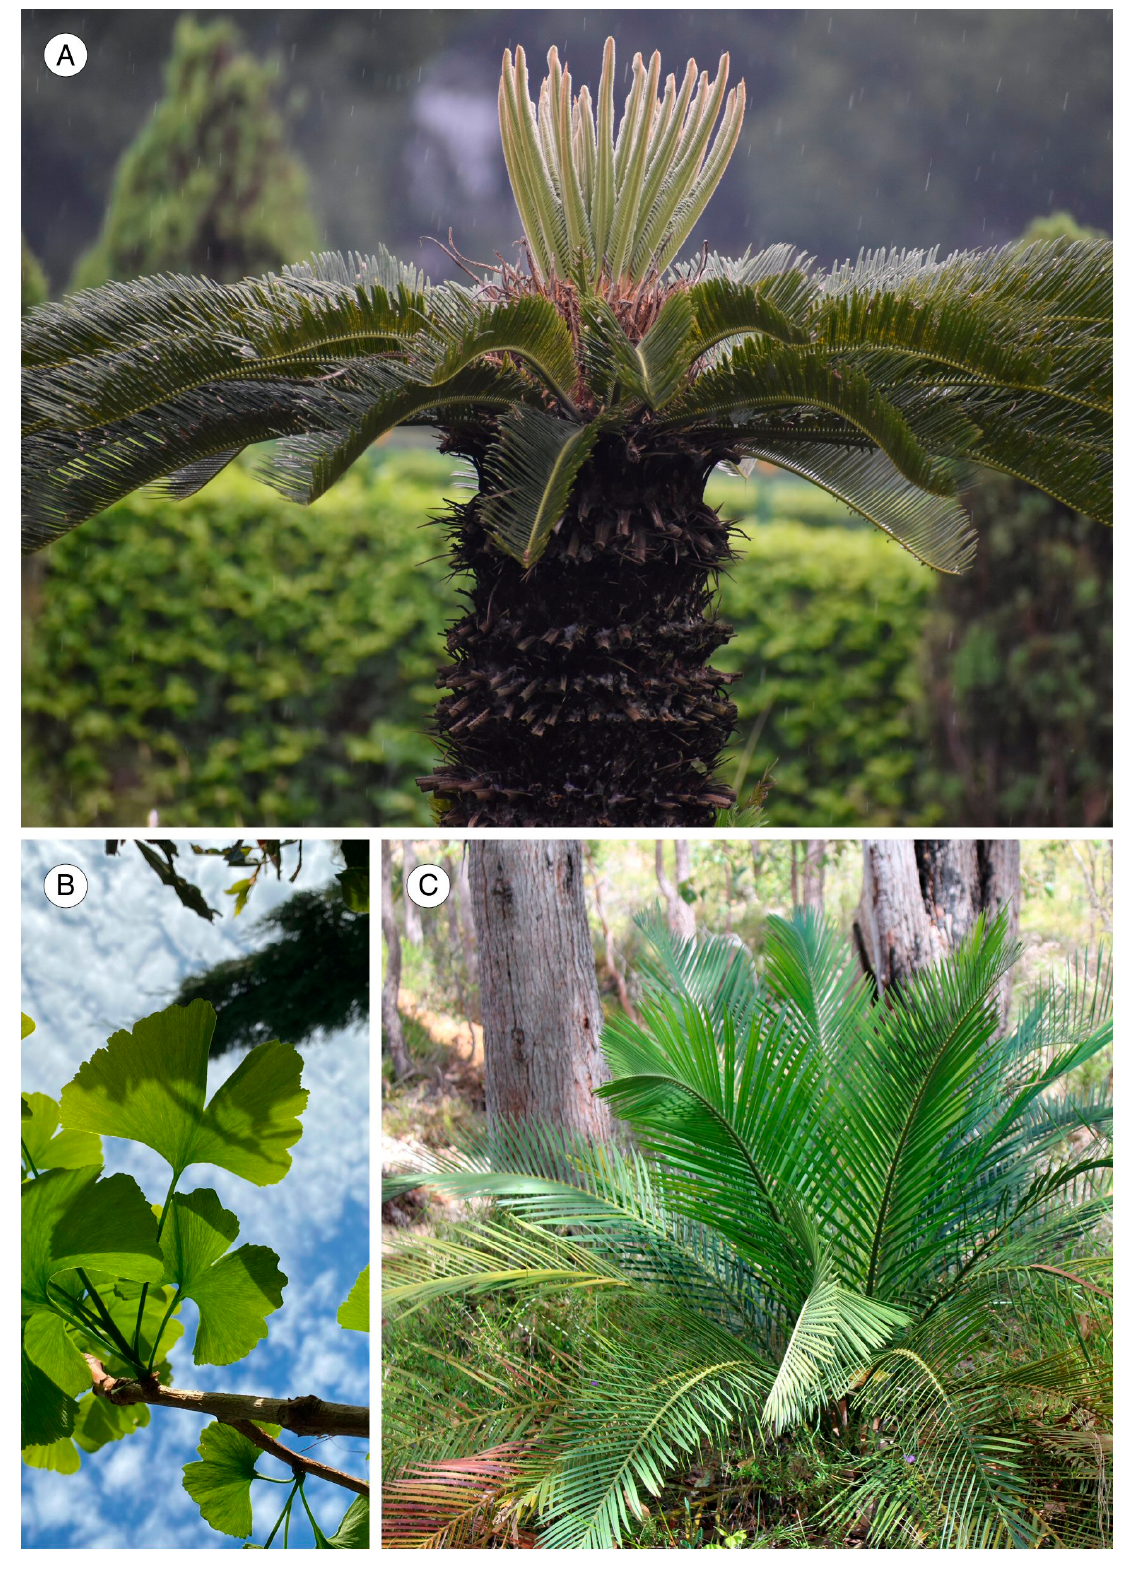
Figure 3. Non-coniferous gymnosperms. ( A ) Cycas revoluta Thunb.; ( B ) Ginkgo biloba L.; ( C ) Zamia sp.